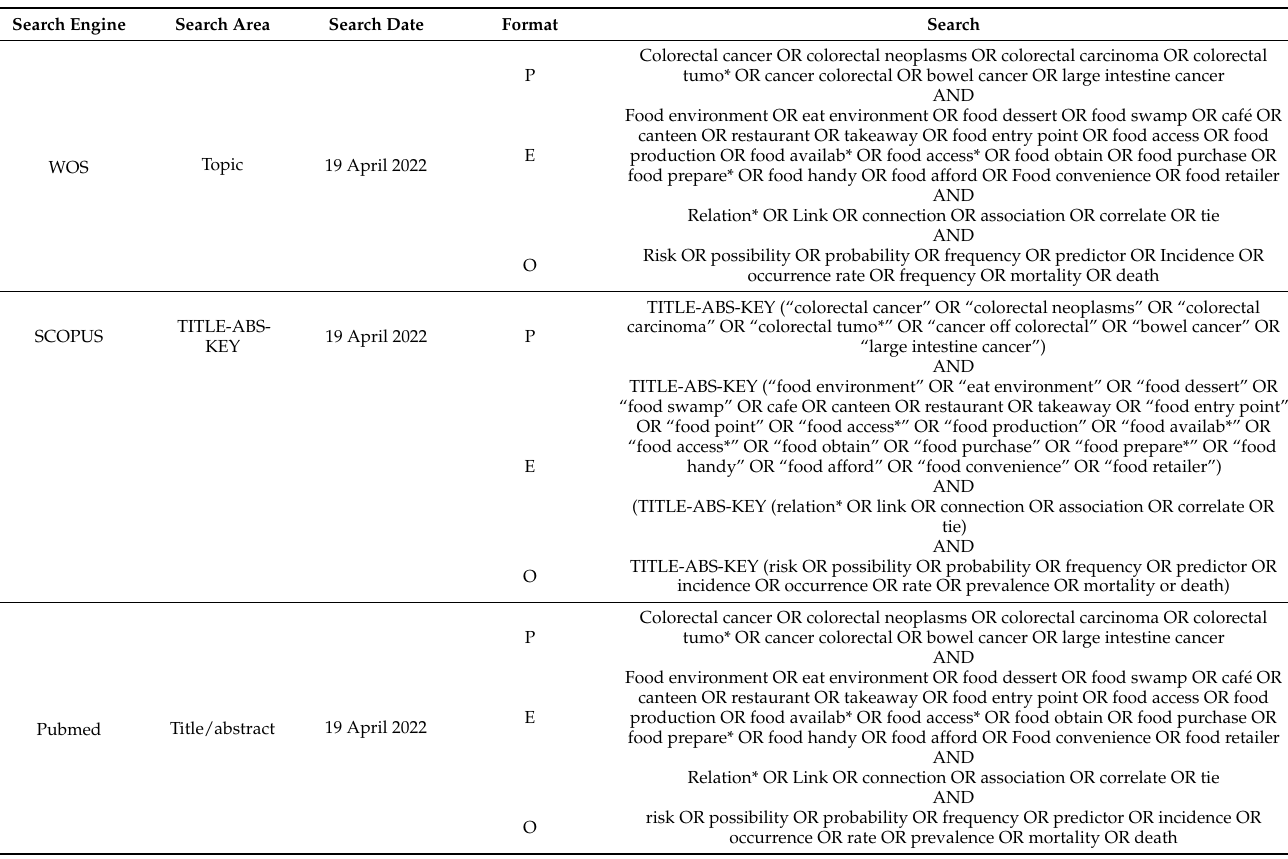
Table 1. A keyword search used in the identification